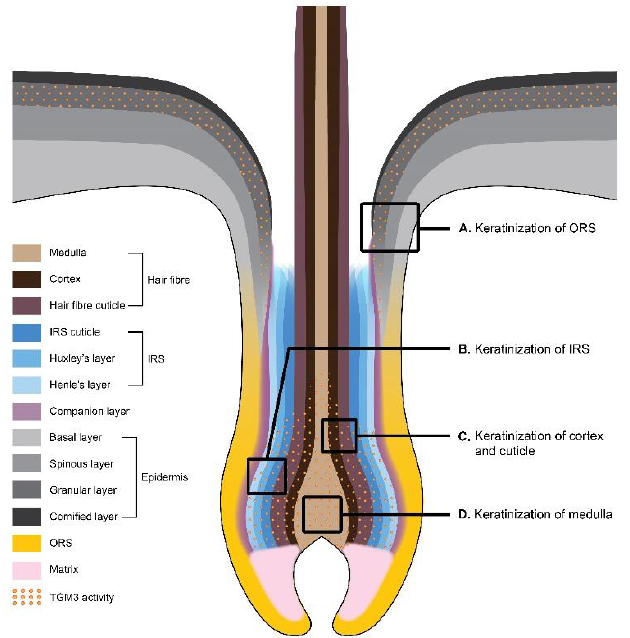
Figure 2. Keratinization in the hair follicle. ( A ) Keratinization of the outer root sheath (ORS). At the infundibulum level, keratinocytes of the hair follicle undergo the same process of cornification as that in the epidermis. Keratinocytes produce filaggrin, which organizes keratin intermediate filaments (KIFs) into tight, oriented bundles. The enzymatic cross-linking of the structural proteins and KIFs results in the CCE formation. TGM3 cross-links loricrin and small proline-rich proteins (SPRs) together in the cytoplasm of granular cells. ( B ) Keratinization of the inner root sheath (IRS). IRS cells produce trichohyalin, which is a functional analog of filaggrin. Trichohyalin becomes cross-linked to itself and—via multiple complex cross-linking—to other structural proteins providing mechanical strength to IRS and supporting the hair shaft growth. TGM3 has been suggested to be the main player in the cross-linking of trichohyalin. ( C ) The keratinization of cortex and cuticle. The hair cortex and the cuticle of the hair shaft are characterized by the expression of the diverse repertoire of keratins and keratin-associated proteins (KAPs). Within the cortex and the cuticle of the hair shaft, KAPs behave as trichohyalin by building the protein matrix that holds together KIFs. TGM3 participates in the cross-linking of the keratins and KAPs promoting the scaffolding of the hair shaft. ( D ) Keratinization of medulla. Medulla cells produce trichohyalin granules. However, due to the deficiency of KIFs, trichohyalin of the medulla cells is cross-linked mainly to itself during differentiation, resulting in the development of large vacuolated spaces. The process is mediated by TGM3.